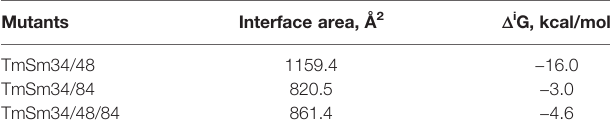
TABLE 1 | Interface area and binding free energy of TmSm proteins with caspase-9 were analyzed by PDBePISA. Mutants Interface area, Å